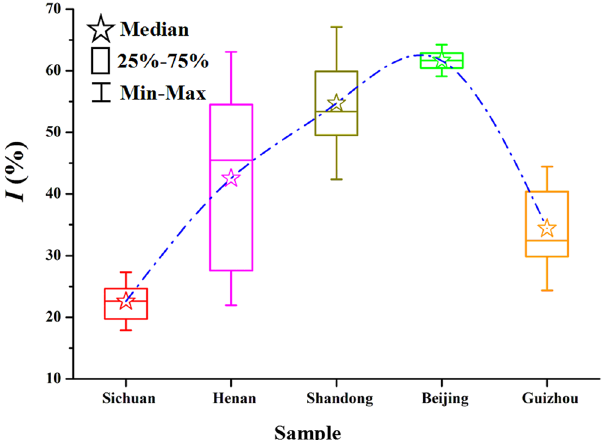
Figure 6. Box and Whisker plots of the inhibition ratio ( I , %). Origin 8.5 software was used to generate these plots and show the minimum and maximum value to indicate the range, the median, 25% and 75%